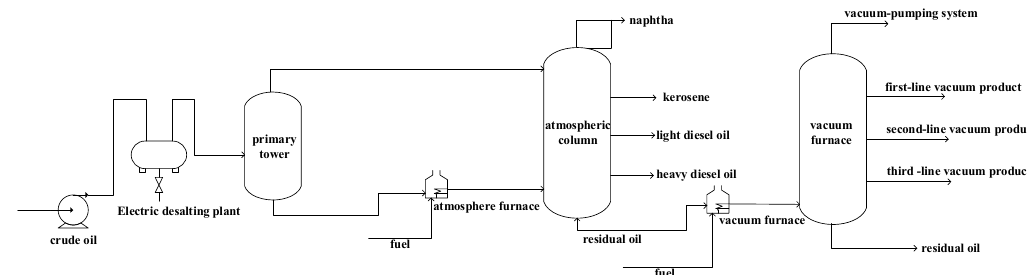
Figure 5. Flow chart of crude distillation.